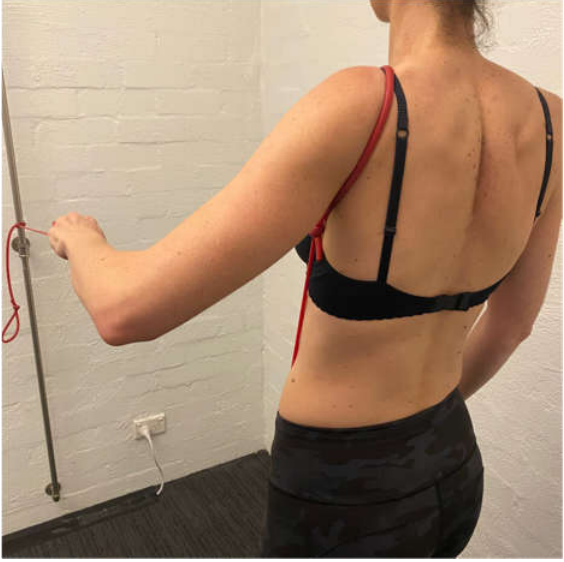
Figure 8. Row at 45 degrees of shoulder